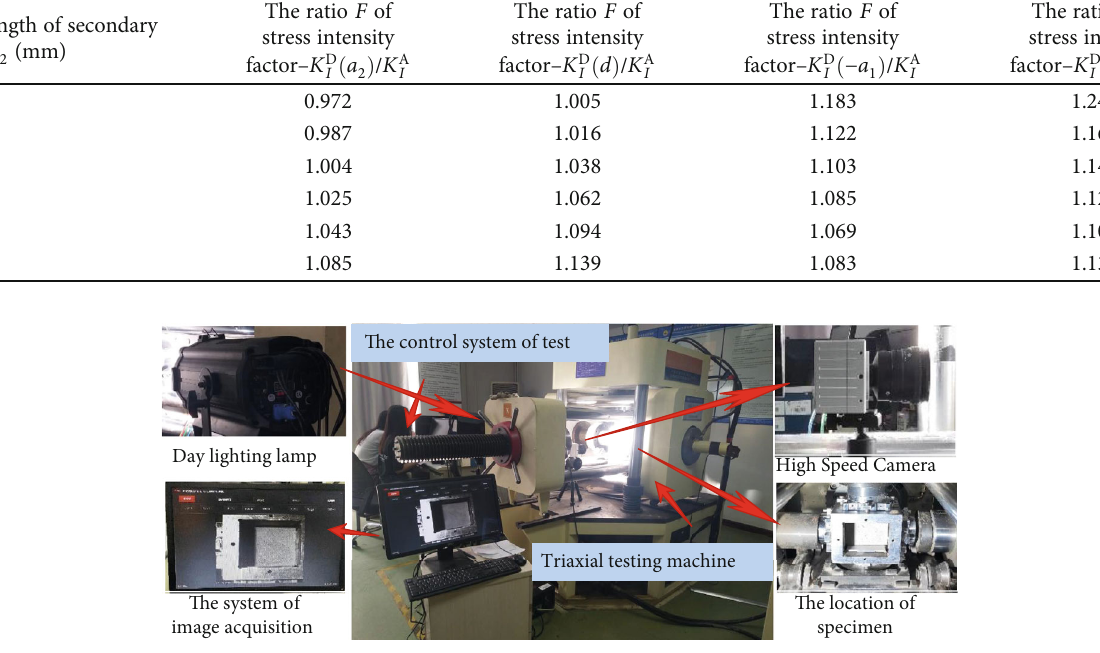
Figure 6: The true-triaxial unloading test